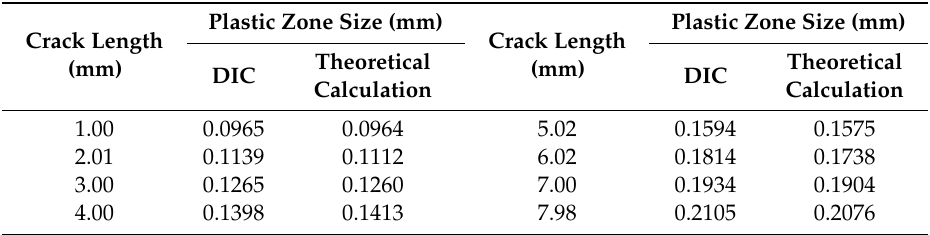
Table 2. The plastic zone size with di ff erent crack lengths under 40